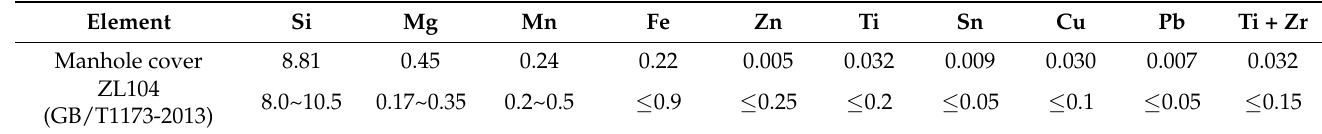
Table 3. Chemical composition of manhole